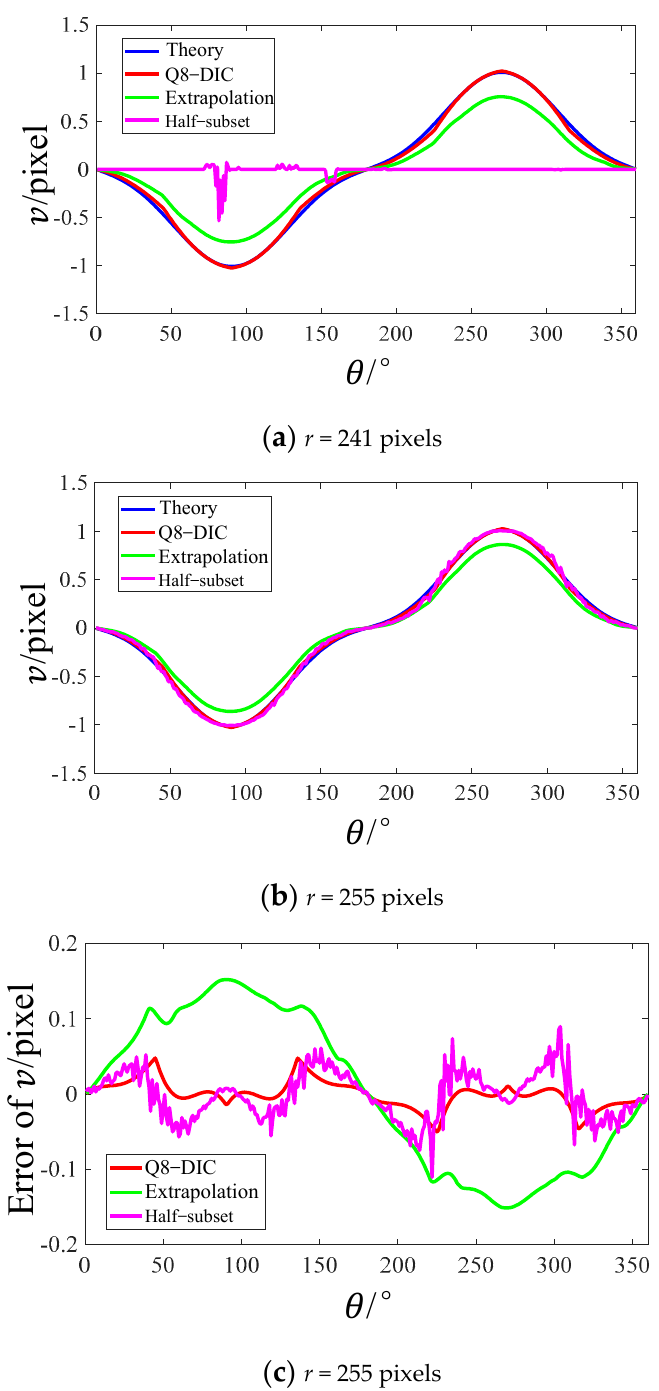
Figure 8. Displacements and measurement errors near the hole edge: ( a ) r = 241 pixels, ( b ) r = 255 pixels, ( c ) measurement errors of displacements ( r = 255